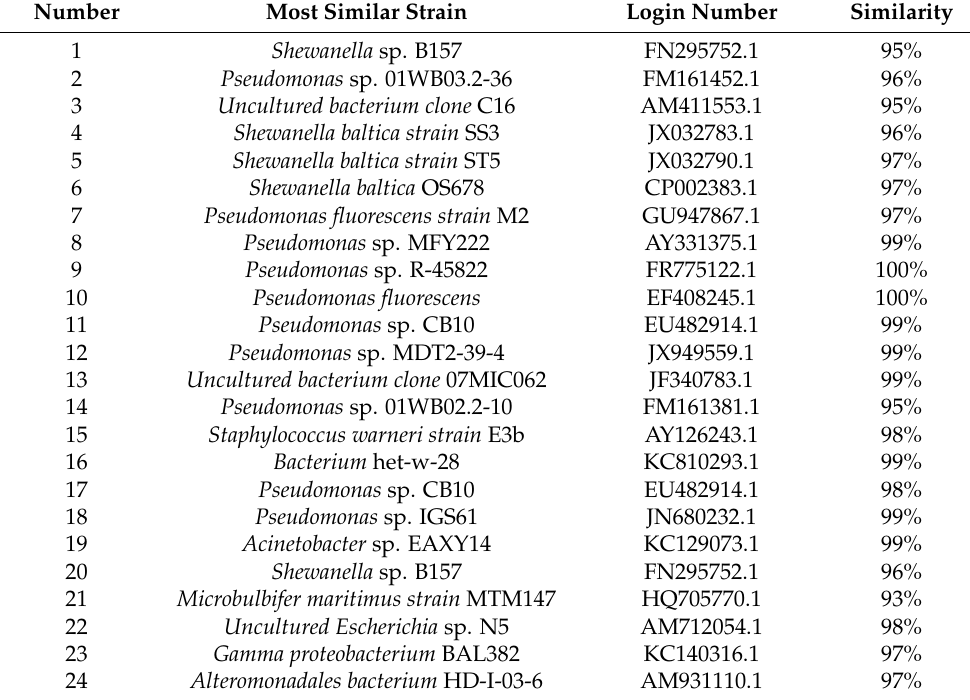
Table 1. 16S rDNA sequence similarities to closest relatives of DNA recovered from DGGE